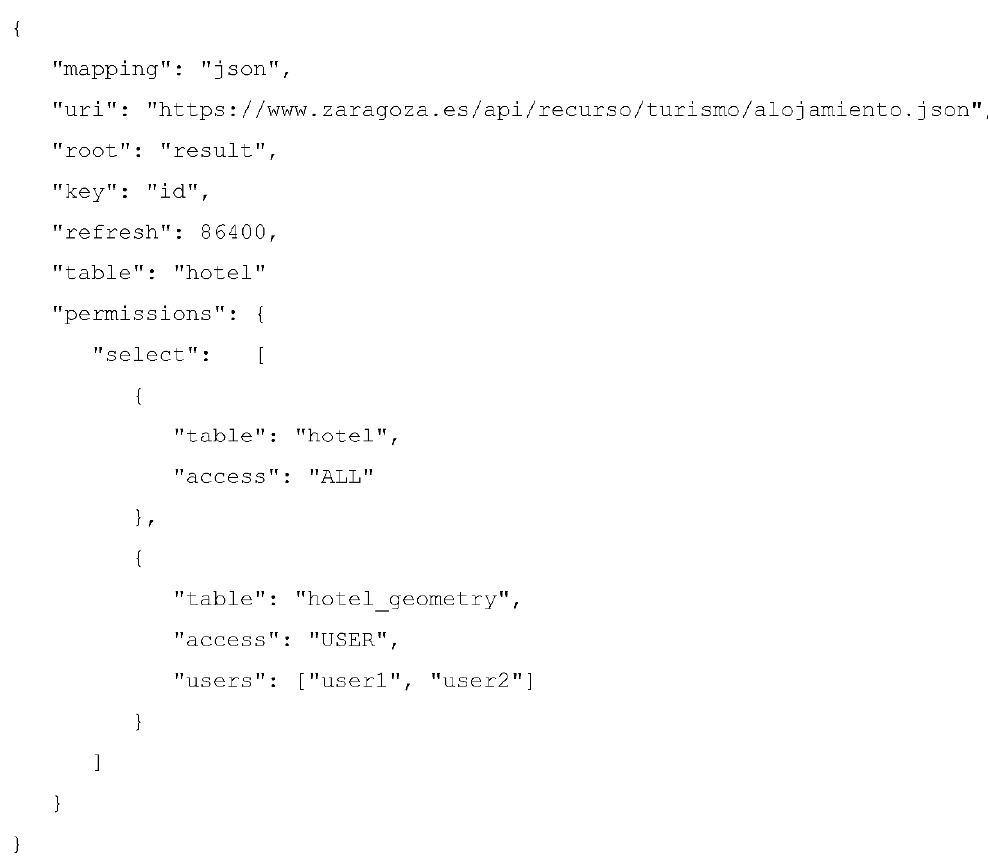
Figure 6. JSON mapping to register accommodation JSON dataset in IES Cities.